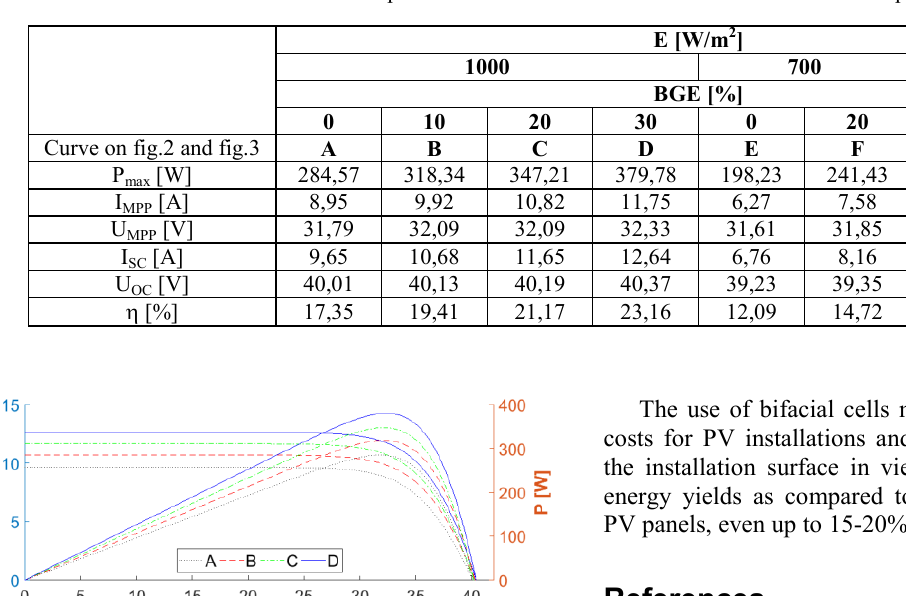
Table 1. Simulation parameters for the LG NeON2 BiFacial LG300N1T-G4 panel.